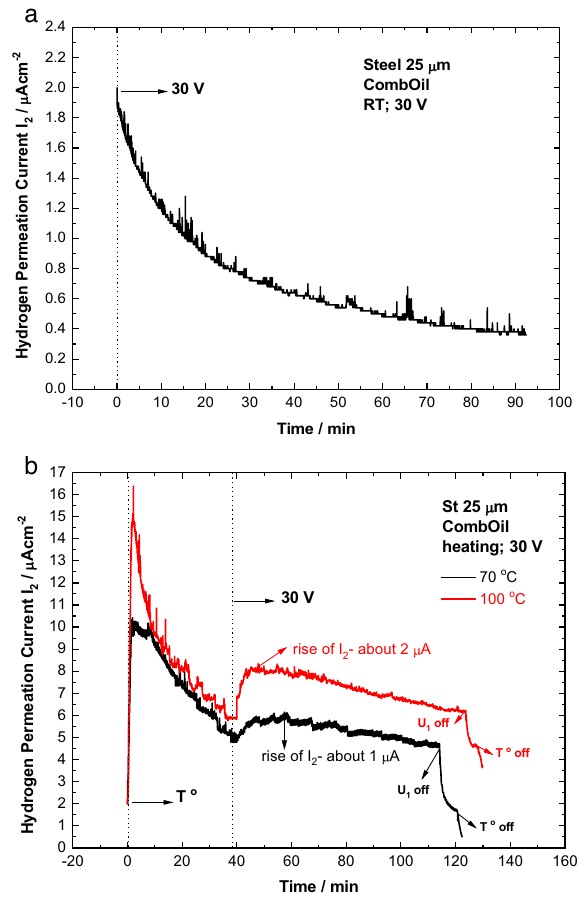
Figure 3. Hydrogen permeation transients, recorded with CombOil under voltage of 30 V at room temperature ( a ) and upon heating at 70 °C or 100 °C ( b ).